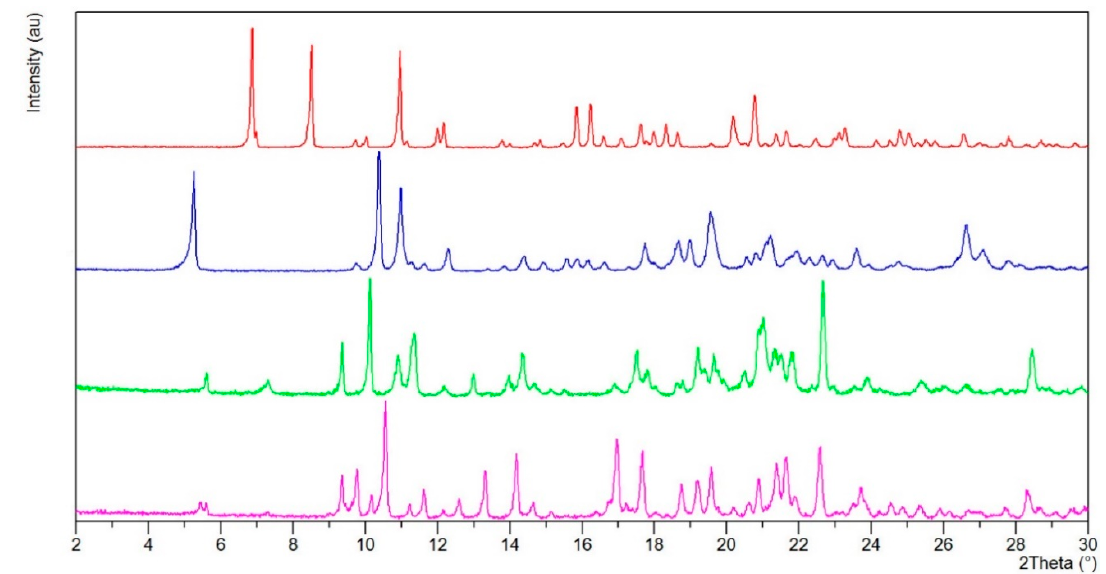
Figure 2. Powder X-ray diffraction patterns of tenofovir alafenamide fumarate derivatives. Red: TA HF; Blue: TA MF1; Green: TA MF2; Magenta: TA MF3.